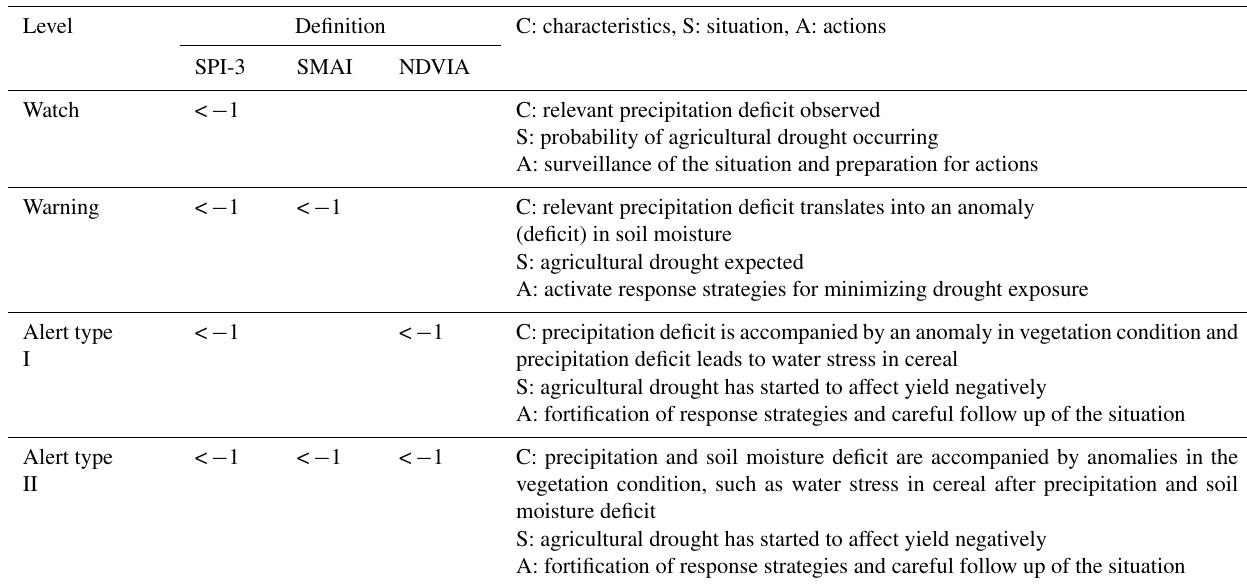
Table 3. Classification of the combined drought indicator